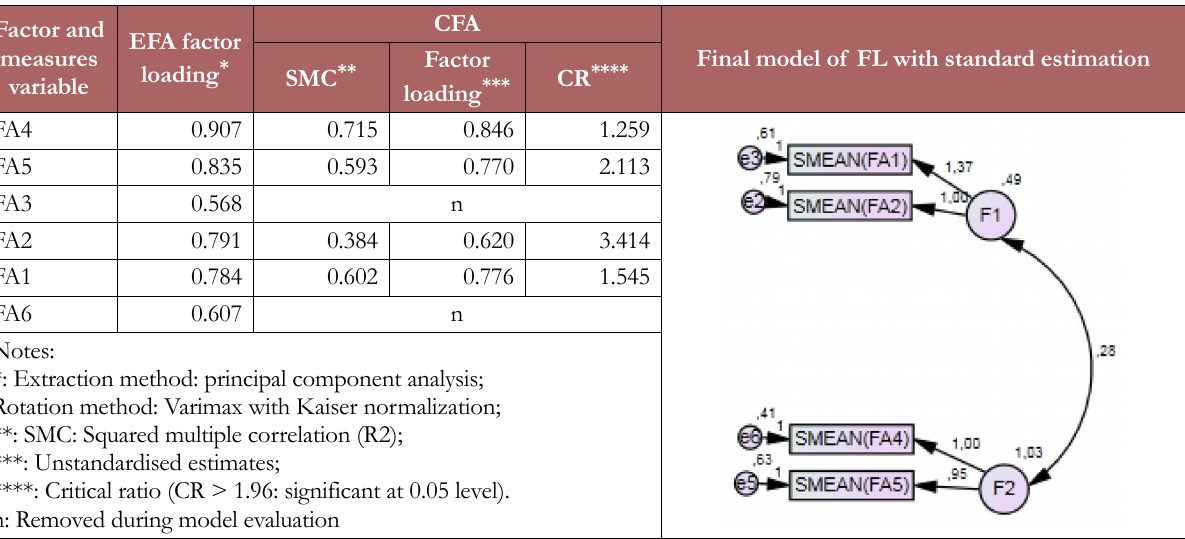
Table 20. EFA and CFA of the FA construct